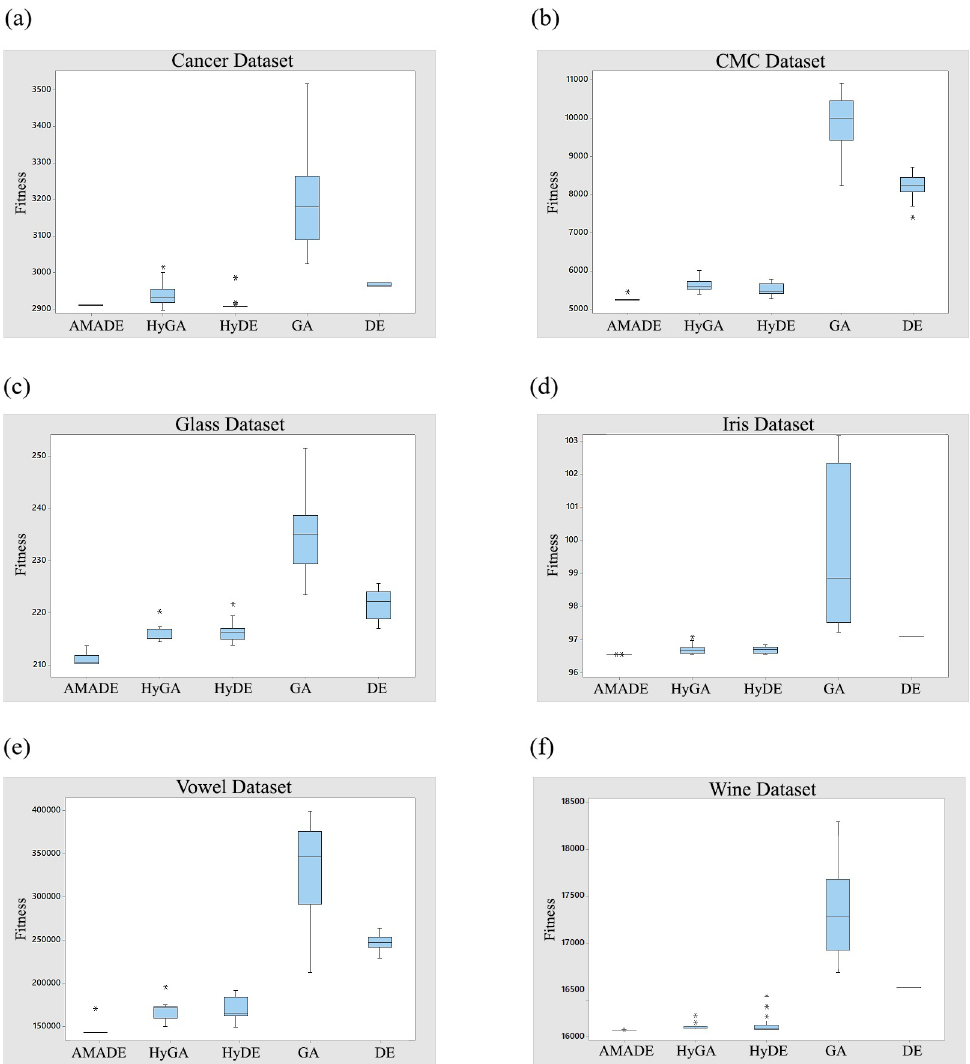
Fig 15. Box plots of fitness of best solutions for AMADE, HyGA, HyDE, GA and DE algorithms on (a) cancer; (b) CMC; (c) glass; (d) iris; (e) vowel; (f) wine